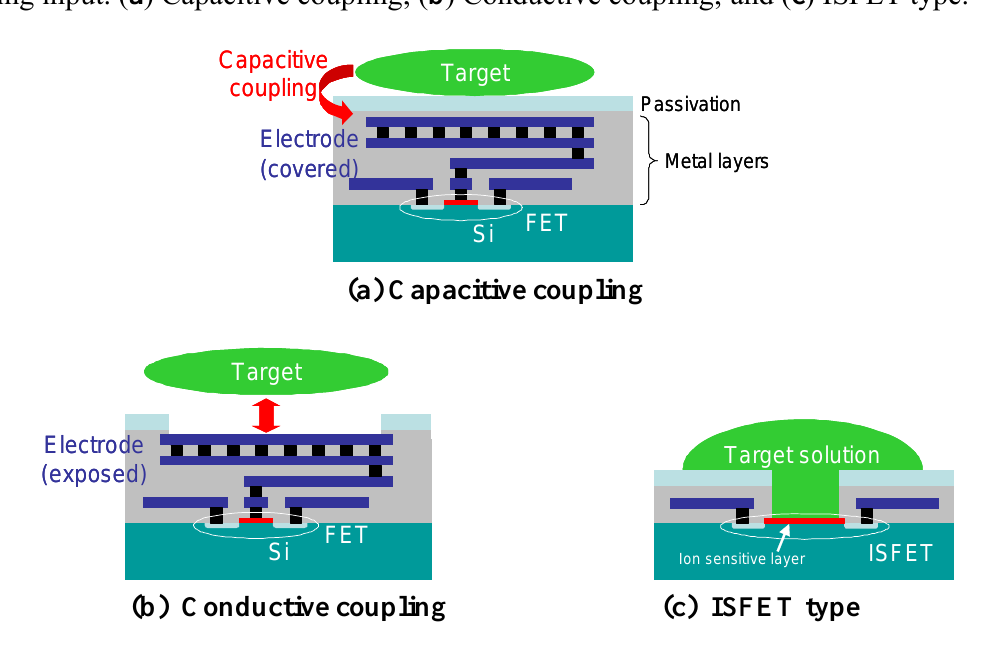
Figure 1. Variations of “passive” electric sensing configurations using the gate of MOS as sensing input. ( a ) Capacitive coupling; ( b ) Conductive coupling; and ( c ) ISFET